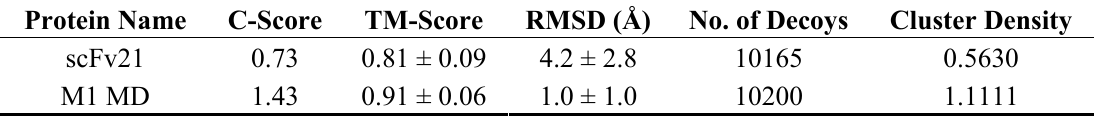
Figure 9. Illustrations of the computerized binding between M1 middle domain and human scFv21. The scFv bound with the least local energy to the residues of helix 7, connecting sequence between helices 7 and 8 and helix 9 of the target protein. Details of the interactive residues between the two parties are shown in Table 2. Table 1. Estimated accuracy of the scFv21 and M1 MD models.